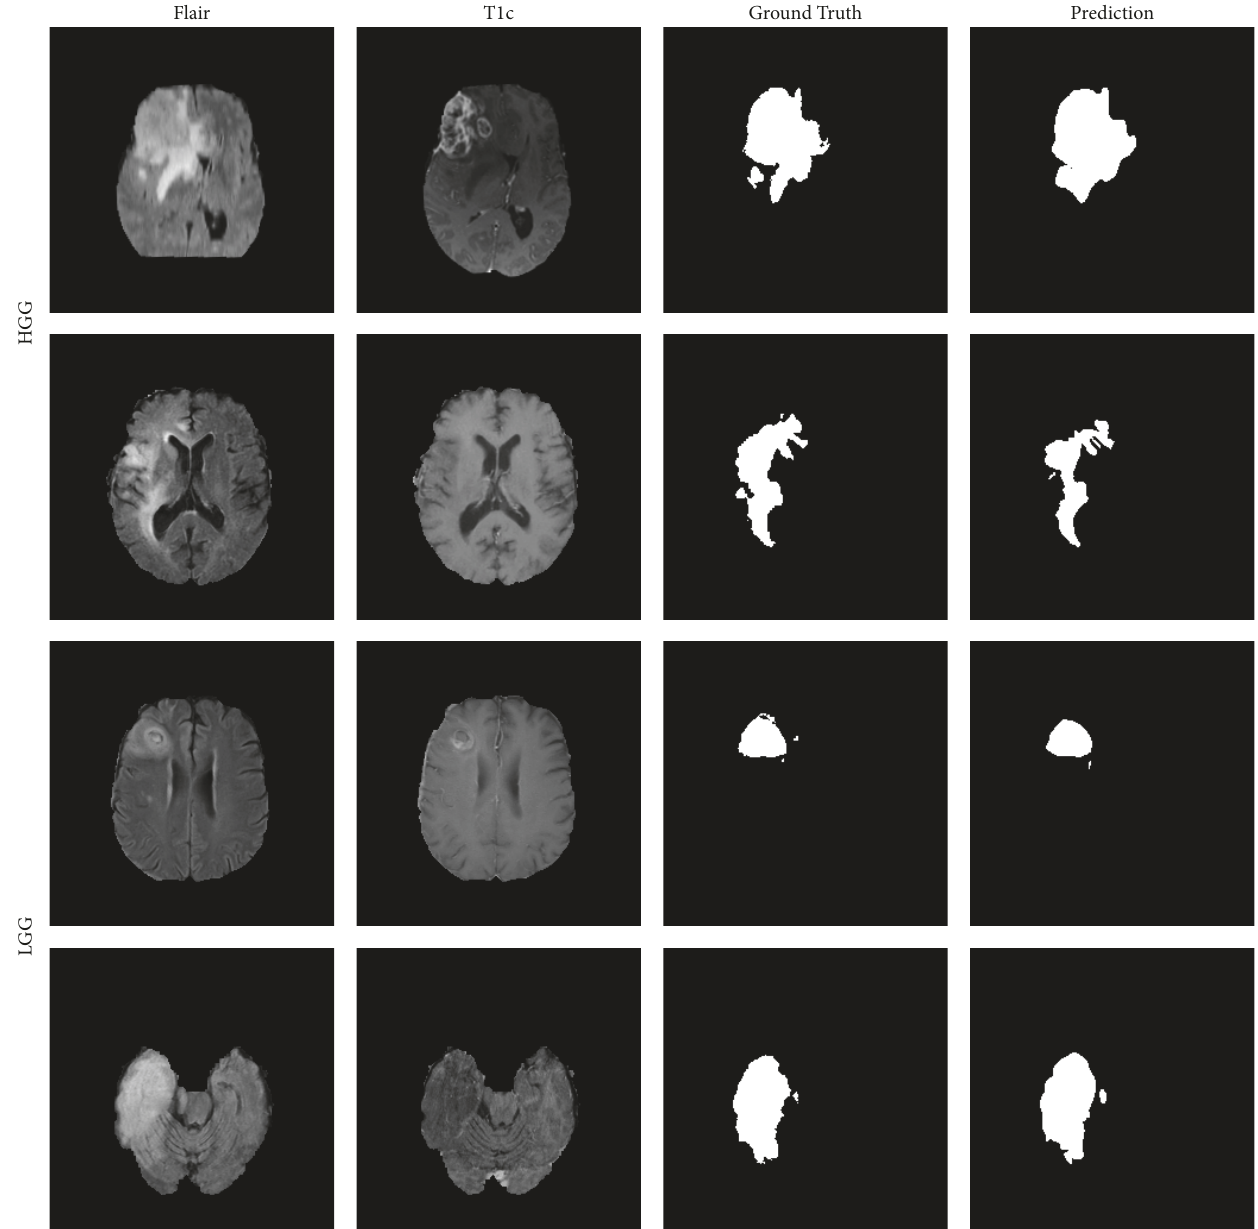
Figure 4: Examples of segmentation